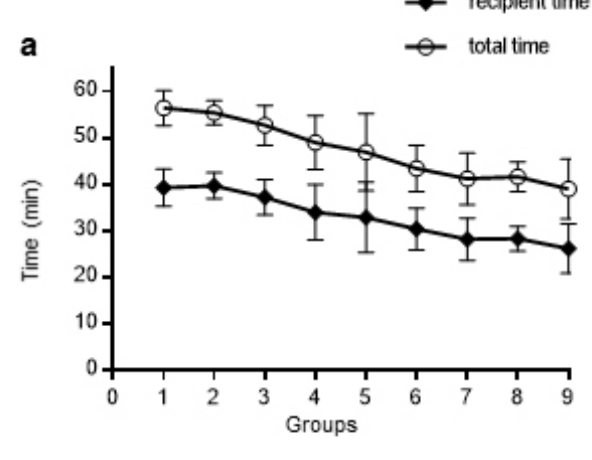
Fig. 5 - Transplantation can be performed in a short time. The total time required for transplantation and the recipient time were short. The recipient time included time of vessel preparation, graft implantation, and recipient incision suture. ***, P <0.005. 321 Brazilian Journal of Cardiovascular Surgery